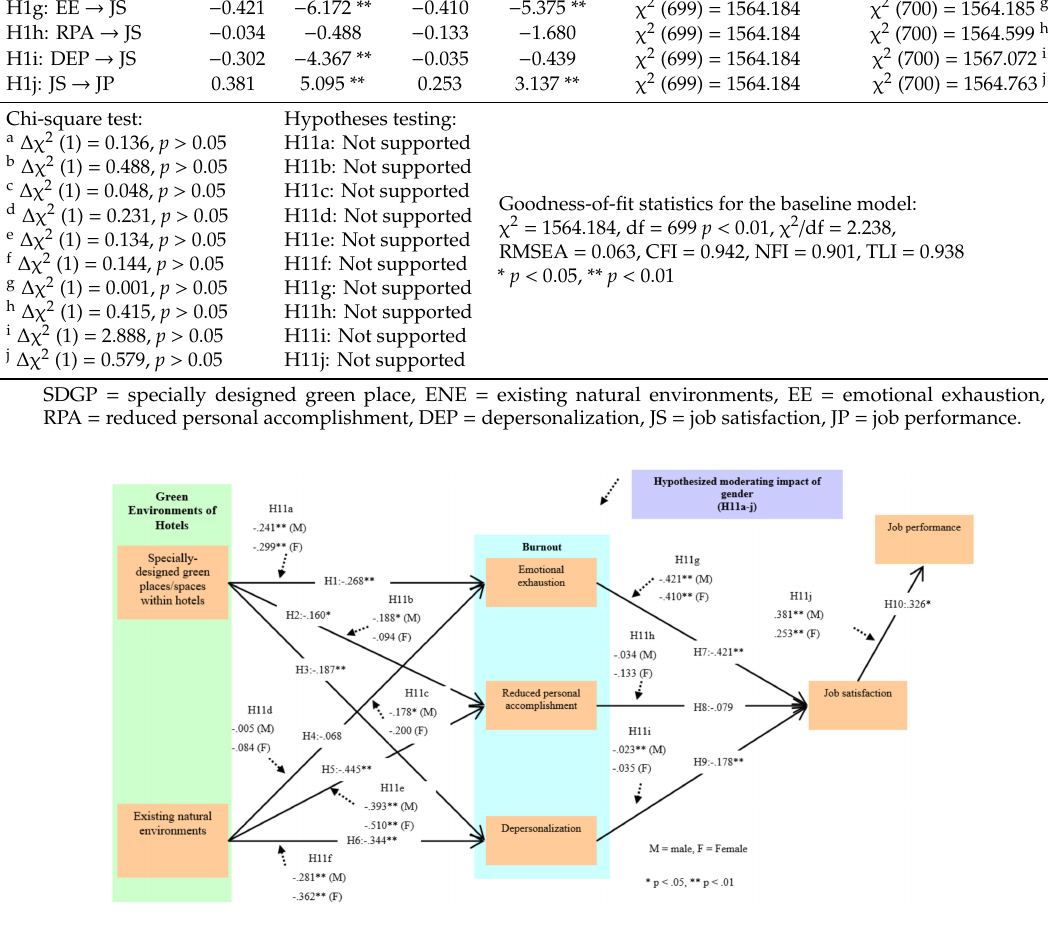
Figure 1. Results of the structural model estimation and baseline model assessment ( n = 309). Goodness-of-fit statistics for the structural model: χ 2 = 963.900, df = 339, p < 0.001, χ 2 / df = 2.764, RMSEA = 0.076, CFI = 0.959, IFI = 0.959, and TLI = 0.955. Goodness-of-fit statistics for the baseline model: χ 2 = 1564.184, df = 699, p < 0.01, χ 2 / df = 2.238, RMSEA = 0.063, CFI = 0.942, NFI = 0.901, TLI =